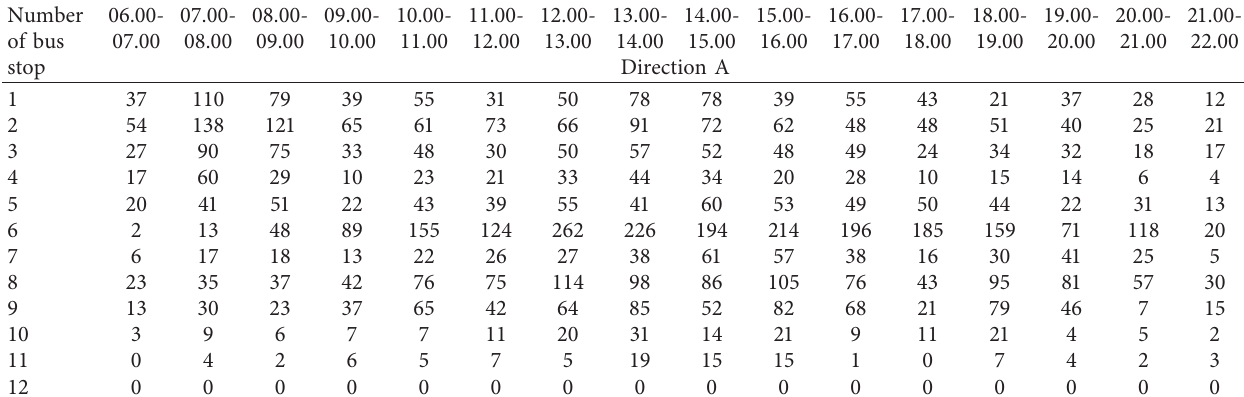
Figure 8: Average value of travel time, by hours in a day, observed in direction B. Table 3: Hour distribution of entries by bus stops, observed in direction A.